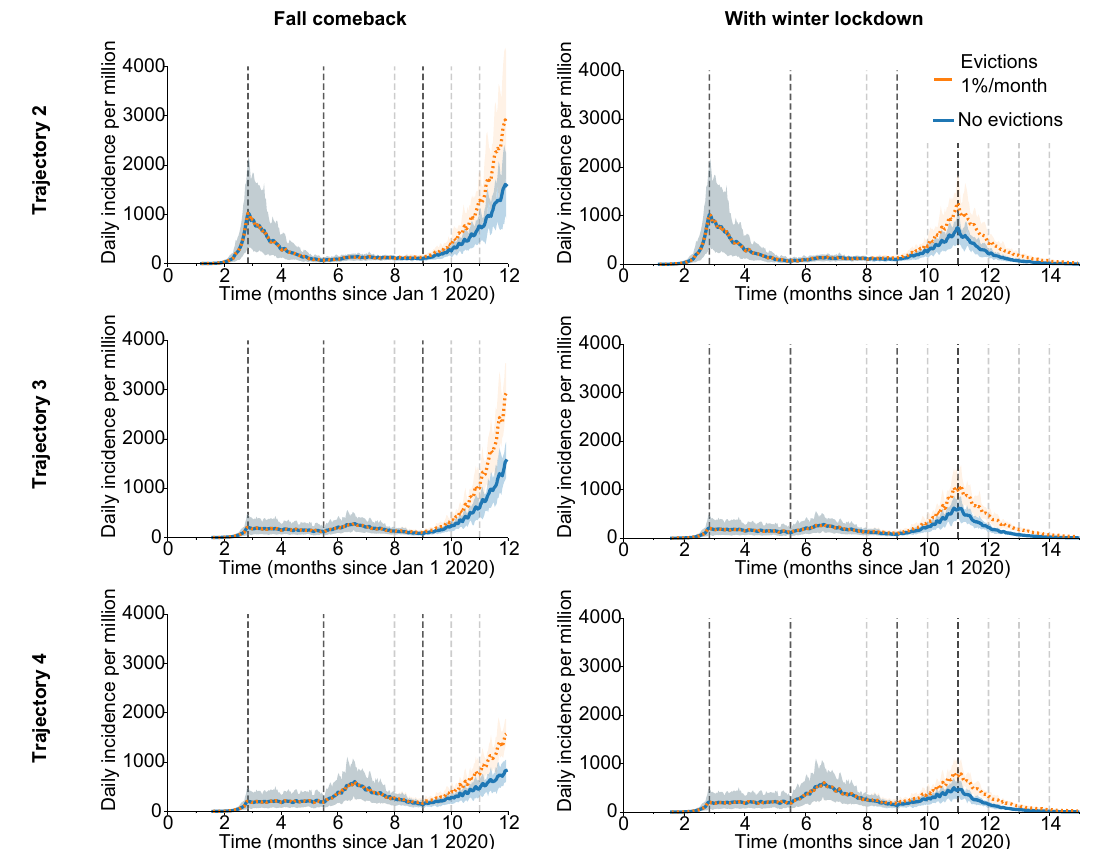
Fig. 3 Alternate epidemic trajectories of SARS-CoV-2 before and after evictions in a large city. Each panel shows the projected daily incidence of new infections (7-day running average) with and without evictions at 1%/month with a 4-month backlog, starting on Sept 1, 2020. Shaded regions represent central 90% of all simulations. In the left column, the spread continues unabated through Dec 31, 2020, whereas in the second column a new lockdown is introduced on Dec 1. Each trajectory scenario is created by calibrating the model to a group of US metropolitan statistical areas with similar patterns of spread (see “ Methods ” section, Supplementary Figs. 5 – 8). For all trajectory types, the degree of reduction in external contacts by control measures was modulated on dates March 25, June 15, July 15, and Oct 1, with values, reported in Supplementary Table